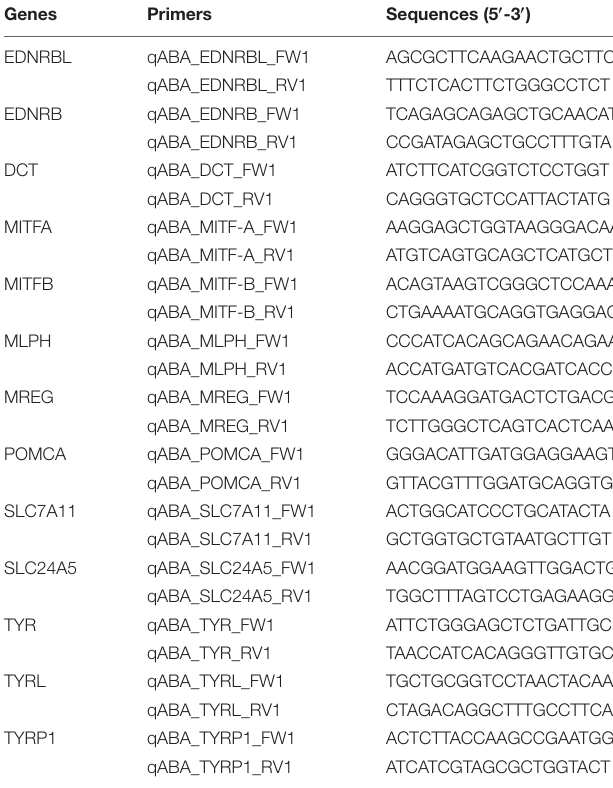
TABLE 1 | Primer information of qRT-PCR validation in this study. Genes